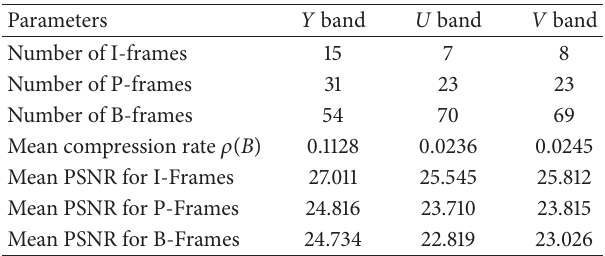
Table 2: Comparison with other methods for “tennis2”